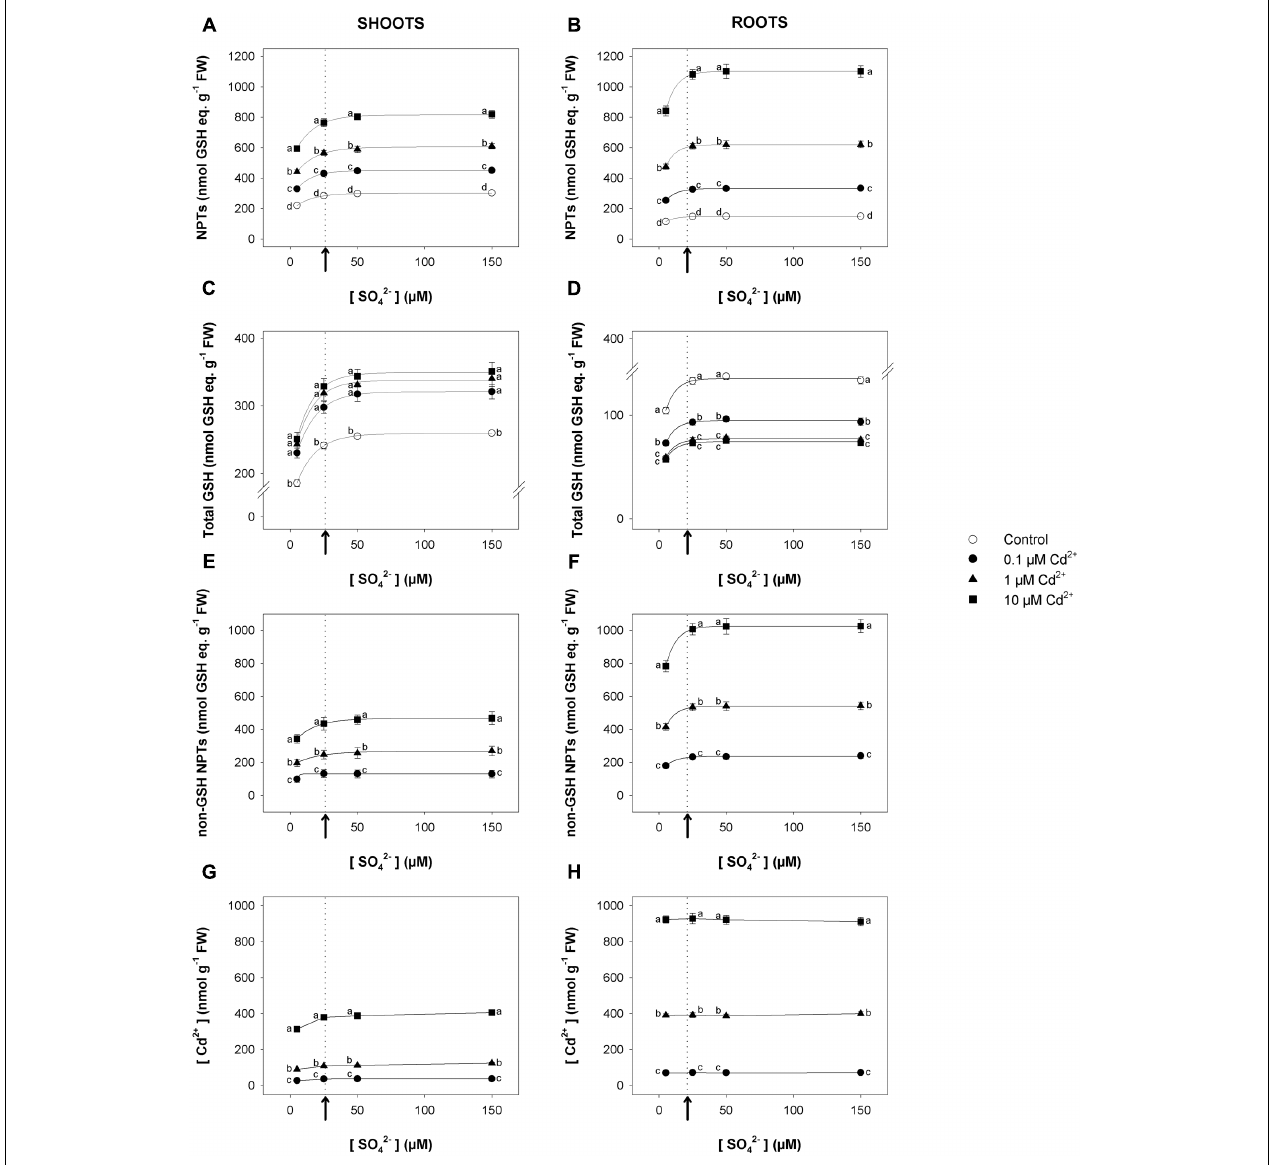
FIGURE 2 | Effect of short-term exposure to Cd on thiol and Cd levels in shoots and roots. Arabidopsis plants were pre-grown for 19 days under four sulfate concentrations (5, 25, 50, and 150 µ M) and then exposed for 72 h to three concentrations of Cd 2 + (0.1, 1, and 10 µ M). NPT levels in shoots (A) and roots (B) ; total GSH levels in shoot (C) and roots (D) ; PC levels in shoots (E) and roots (F) ; Cd contents in shoots (G) and roots (H) . Data are means and SE of two experiments run in triplicate ( n = 6). Different letters indicate significant differences ( P < 0.05). Dotted lines and arrows indicate [SO 42 − ] crit